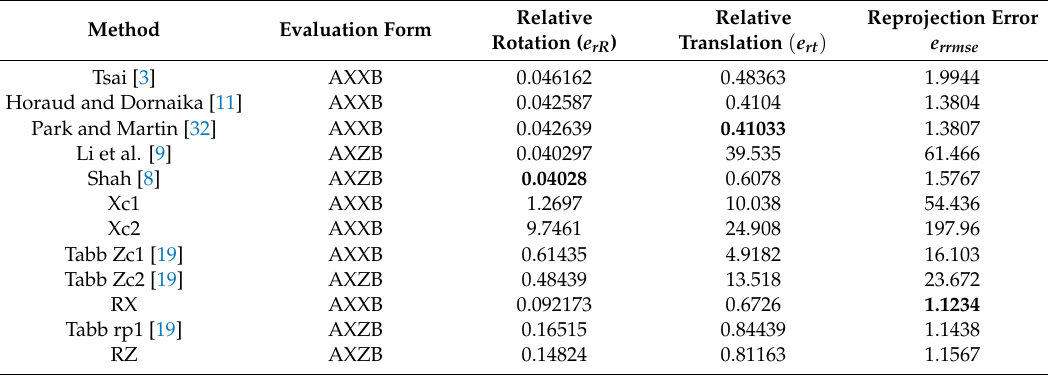
Table 3. Comparison of methods using the described error metrics for dataset 2.